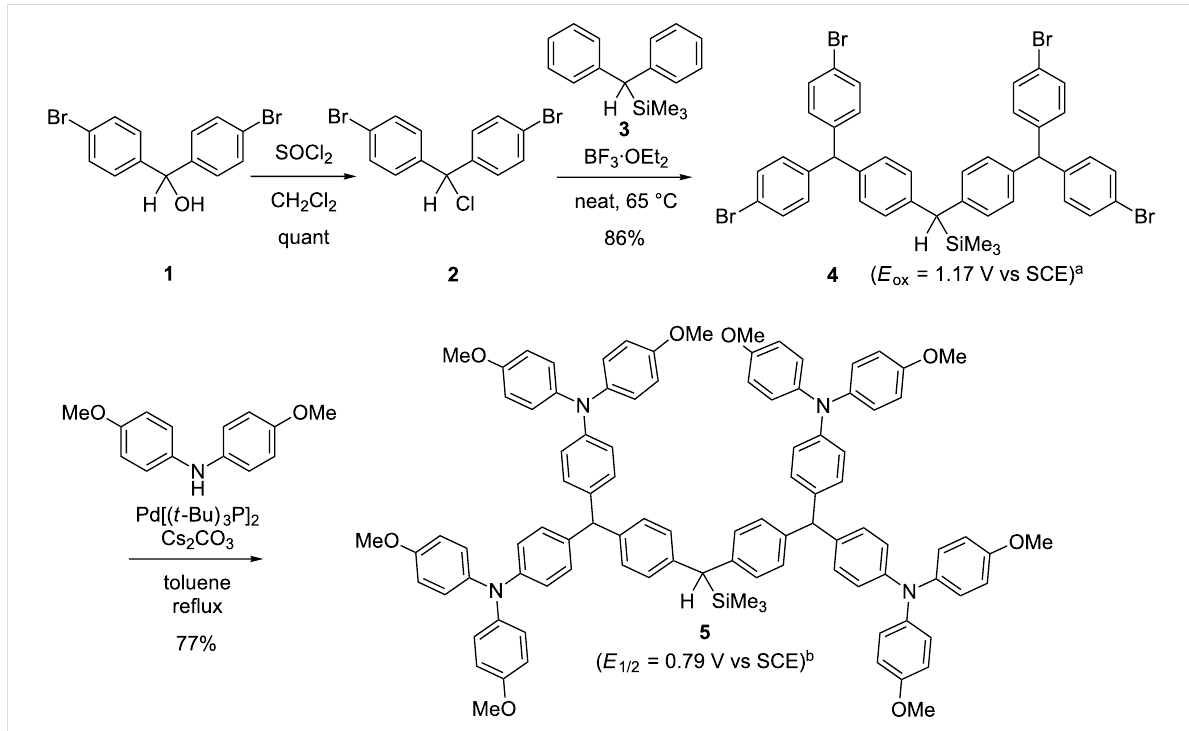
Figure 2: Preparation of the dendrimer having peripheral bromo groups and their conversion to diarylamino groups. a Oxdation potential ( E ox ). b Redox potential ( E 1/2 ).